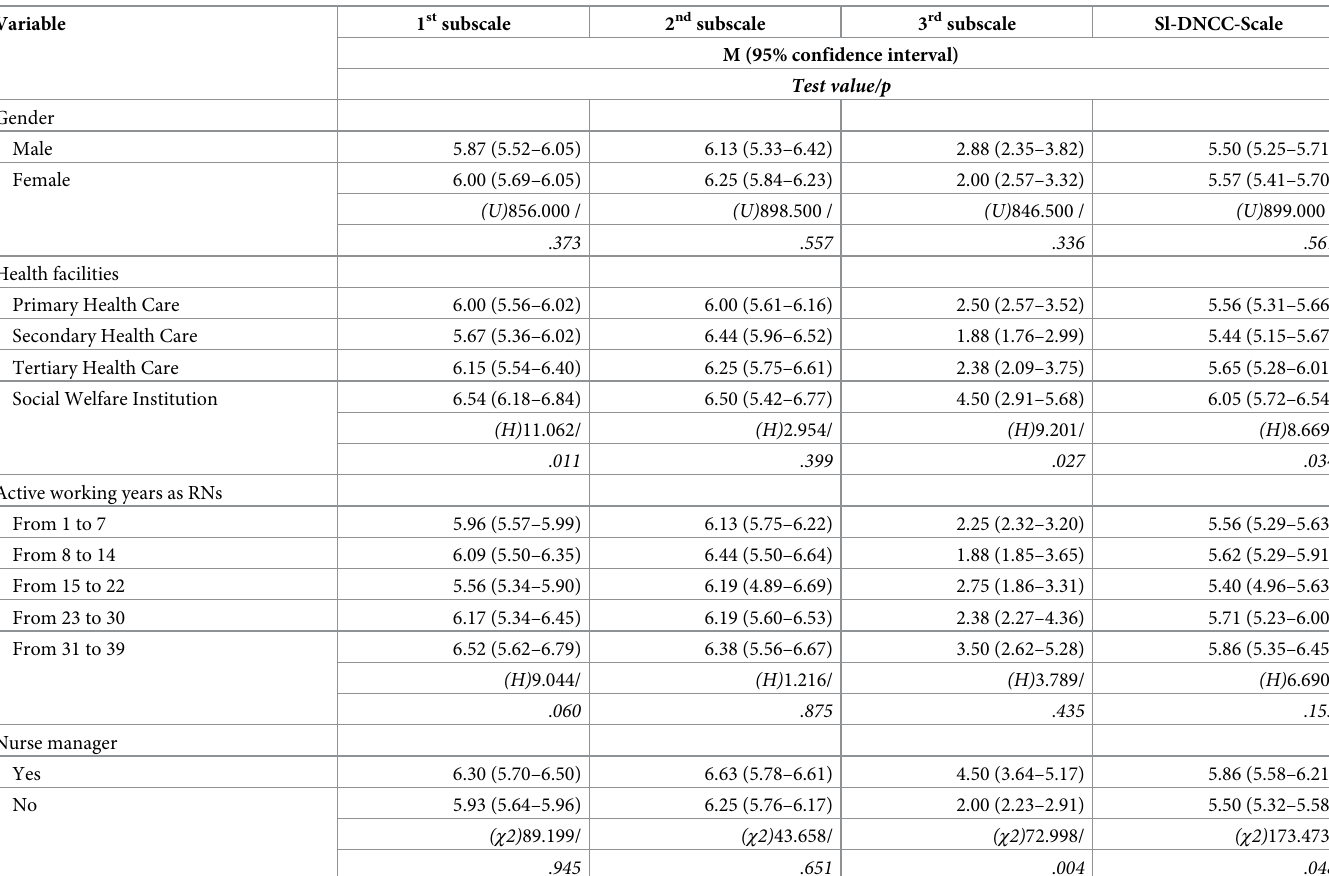
Table 3. Demographic characteristics of the sample population concerning the Sl-DNCC-Scale and the three subscales.